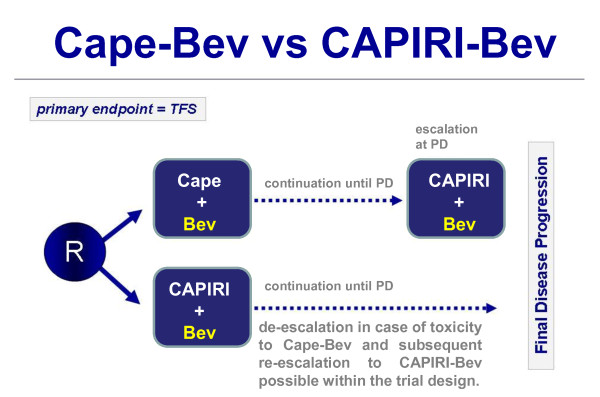
Flow chart of the AIO KRK 0110 Trial/ML22011 Trial. Patients are randomized to either receive single-agent chemotherapy (Cape-Bev) and escalation to CAPIRI-Bev at progressive disease or combination chemotherapy (CAPIRI-Bev) with an de-escalation option to Cape-Bev and subsequent re-escalation if necessary.